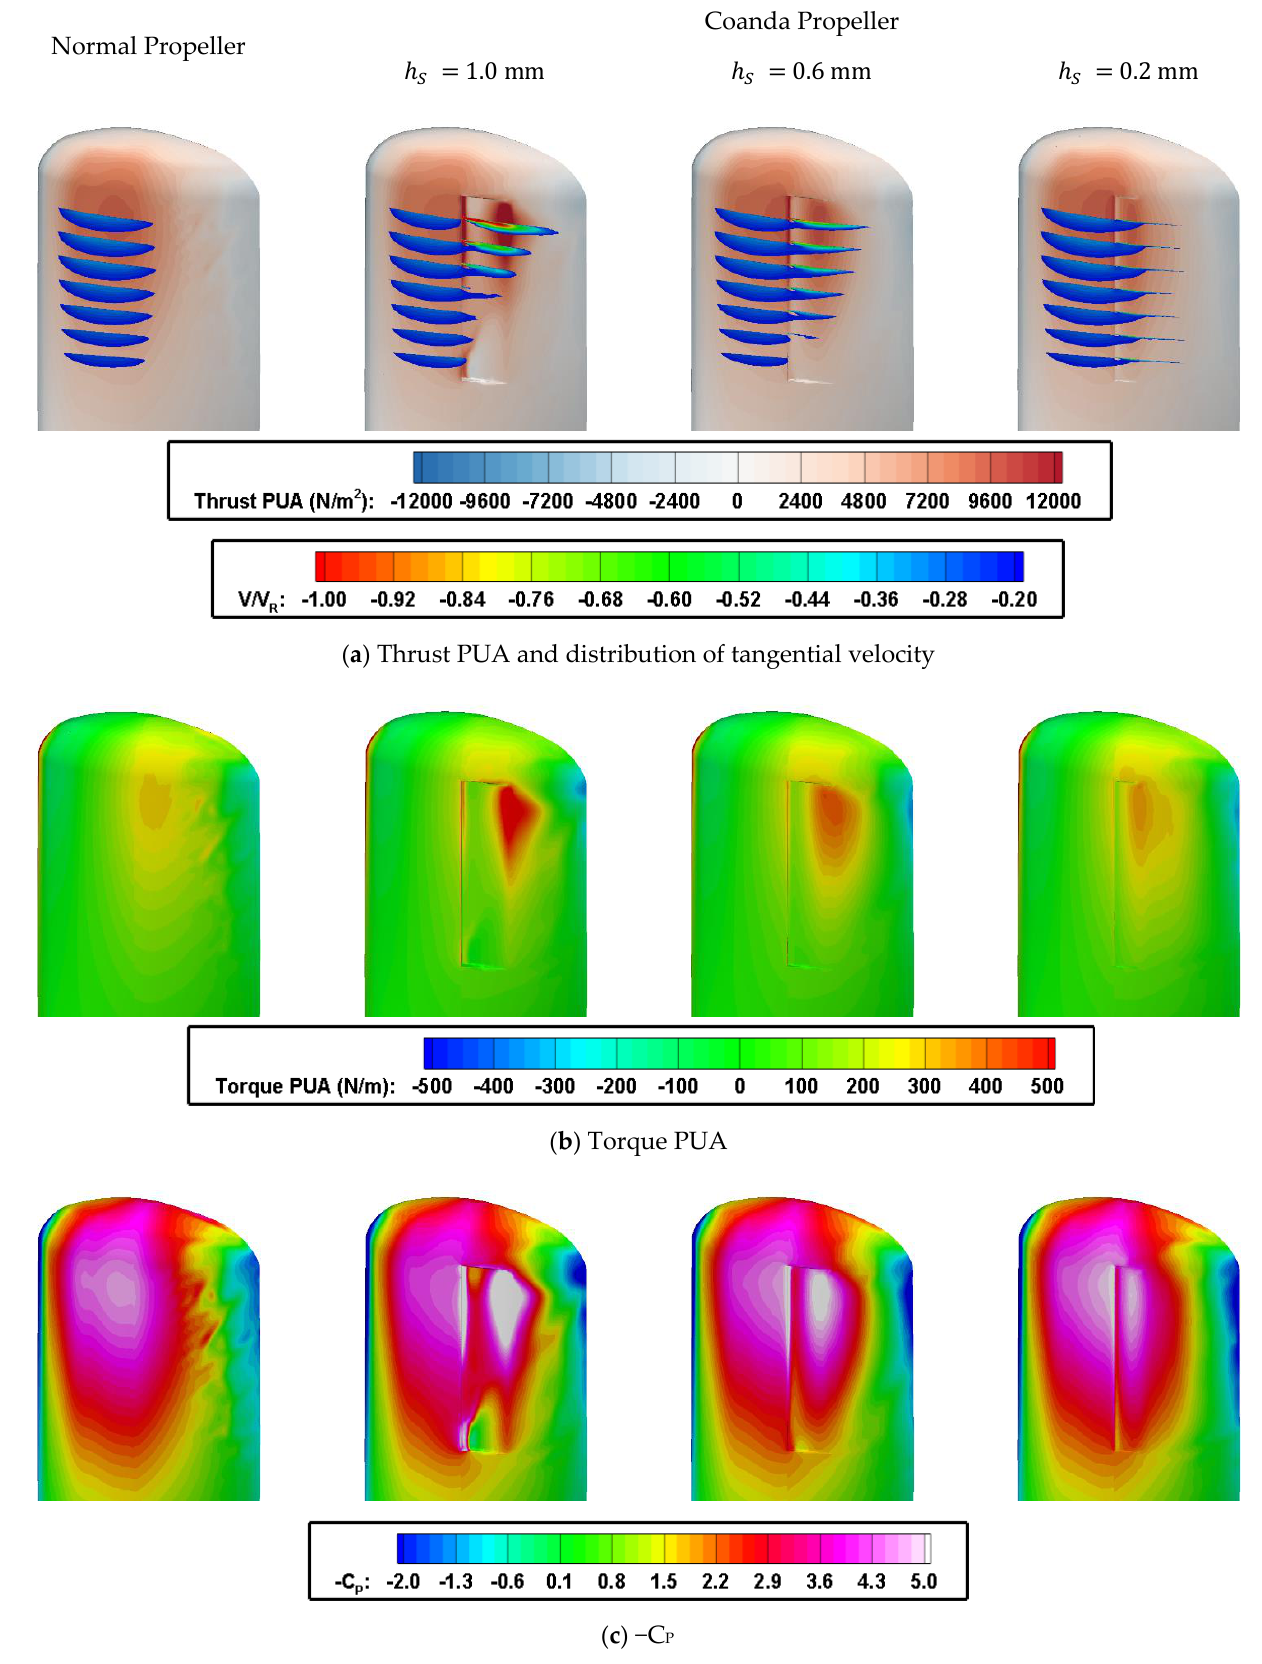
Figure 20. Comparison of changes in hydrodynamic force on the surface of a normal propeller and Coanda propellers (NACA66 (MOD, t/c = 0.24)).